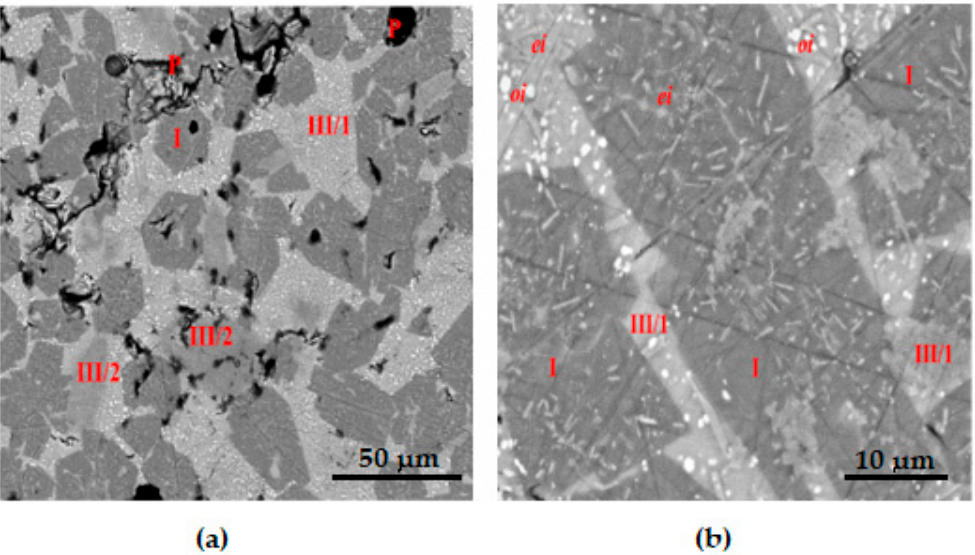
Figure 3. Texture of CCS. ( a ) I, cordierite; III / 1, amorphous phase; III / 2, amorphous phase; P, pores; ( b ) Inclusions in texture of CCS. I, cordierite with II, enstatite inclusion ( ei ) and III / 1, amorphous phase ( oi, other not identified inclusion and ei ).